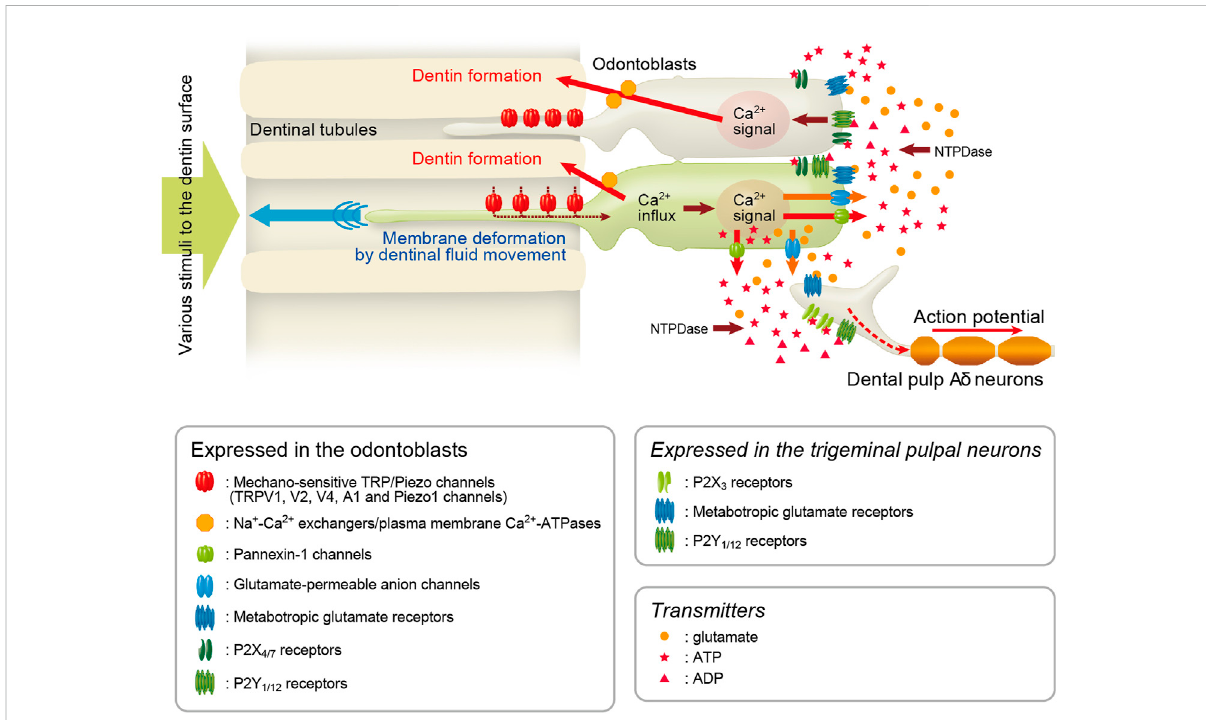
FIGURE 10 Odontoblast mechanosensory/hydrodynamic receptor model explains dentinal sensitivity Schematic representation of signal transduction pathway in odontoblast-neuron coupling in the generation of dentinal sensitivity, showing the “ odontoblast mechanosensory (or hydrodynamic) receptor model. ” Odontoblasts detect the cellular deformation by hydrodynamic force via dentinal fl uid movements inside dentinal tubules using mechanosensitive Piezo1 channels, TRPVs, and TRPA1 channels. TRP/Piezo1-mediated intracellular Ca 2+ signals elicit the release of ATP from ATP-permeable PANX-1 in odontoblasts. The released ATP acts as the predominant neurotransmitter for P2X 3 receptors on pulpal A δ neurons to drive thesensorytransductionsequence underlyingdentinal sensitivity. Additionally,glutamatereleased from glutamate-permeable anion channels by activation of mechanosensitive ion channels in odontoblasts activates metabotropic glutamate receptors (mGluRs) in neurons, establishing the odontoblast-neuron communication (Nishiyama et al., 2016) underlying dentinal sensitivity. During the mechanosensory transduction sequence in odontoblasts, increased intracellular Ca 2+ levels following Ca 2+ entry from TRP channels is extruded by Na + -Ca 2+ exchangers (NCXs) and plasma membrane Ca 2+ -ATPase (PMCA) to drive reactionary (tertiary) dentinogenesis (Tsumura et al., 2010; Sato et al., 2013; Kimura et al., 2021). In addition to the sensory transduction mechanism, ADP hydrolyzed from ATP by nucleoside triphosphate diphosphohydrolases (NTPDases) and glutamate released from odontoblasts activate P2Y 1 and P2Y 12 receptors (Sato et al., 2015; Shibukawa et al., 2015), and mGluRs (Nishiyama et al., 2016), respectively, in the surrounding odontoblasts in an autocrine/paracrine manner, forming inter-odontoblast communication. Odontoblasts also functionally express P2X 4 and P2X 7 receptors (Lee et al., 2017; Shiozaki et al., 2017), which may contribute to paracrine signaling in odontoblast- odontoblast communication. The inter-odontoblast signal networks may also contribute to precise regulatory mechanisms in developmental/ tertiary dentinogenesis in the dentin-pulp complex. In addition, exposure of the dentin surface to high pH stimuli (e.g., dental materials such as calciumhydroxideormineraltrioxideaggregate)inducesintracellularCa 2+ mobilization via activationofTRPA1channelsand/orstore-operatedCa 2+ entry (SOCE) in odontoblasts (Shibukawa and Suzuki, 2003; Tsumura et al., 2013; Kimura et al., 2016, 2018). NCXs and PMCAs in odontoblasts are functionallycoupledwithhighpHstimulation-inducedCa 2+ mobilization,whichisimportantforphysiologicalandhigh-pH-induceddentinogenesis (Kimuraetal., 2016, 2021).Our recentresults also indicate “ retrograde ” communication between neurons andodontoblasts via neuropeptides,